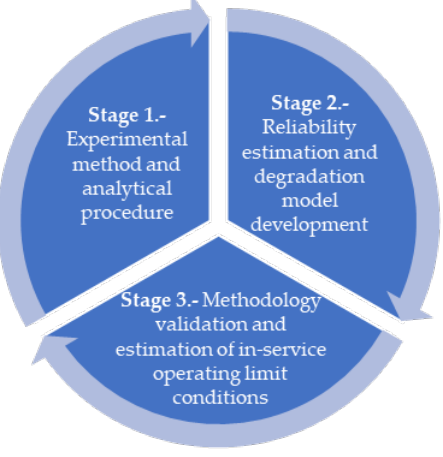
Figure 1. Methodology of